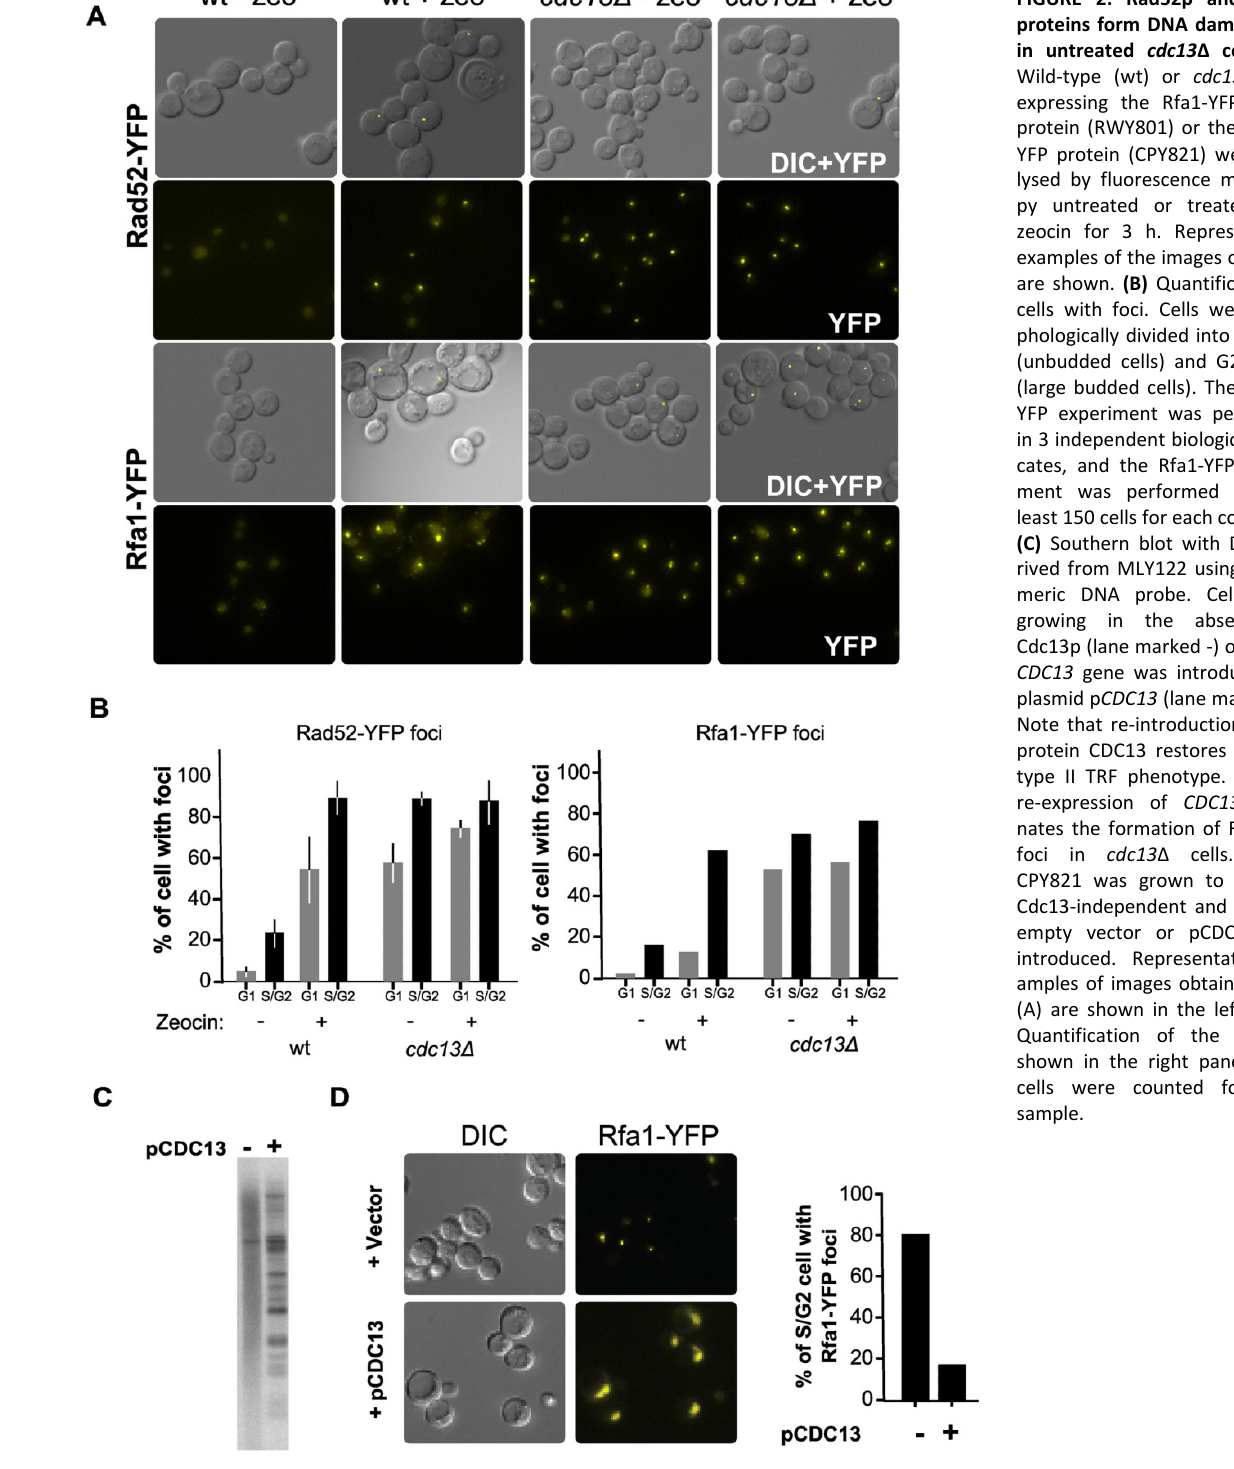
FIGURE 2: Rad52p and Rfa1p proteins form DNA damage foci in untreated cdc13 Δ cells. (A) Wild-type (wt) or cdc13 Δ